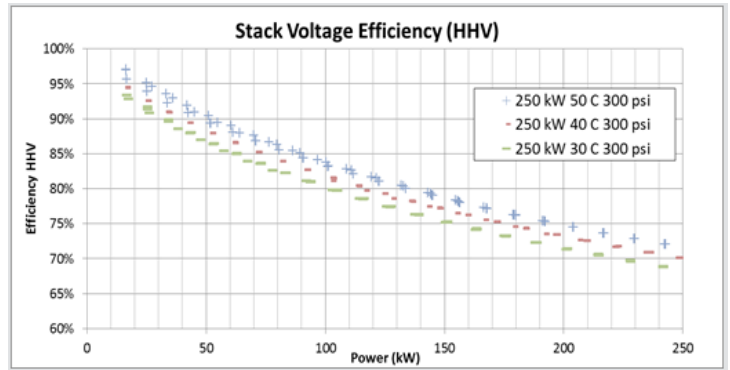
Figure 5. Electrolyzer stack efficiency is shown to decrease with increasing current and decreasing temperature for the 250 kW stack.